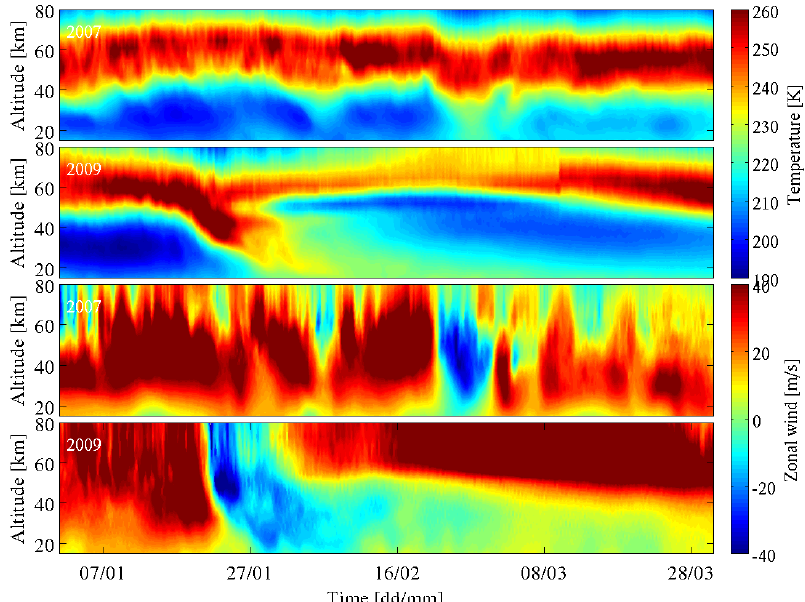
Fig. 2. ECMWF zonal mean temperature (K) and zonal mean zonal wind (ms − 1 ) at 75 ◦ N as a function of time and altitude for winters 2007 and